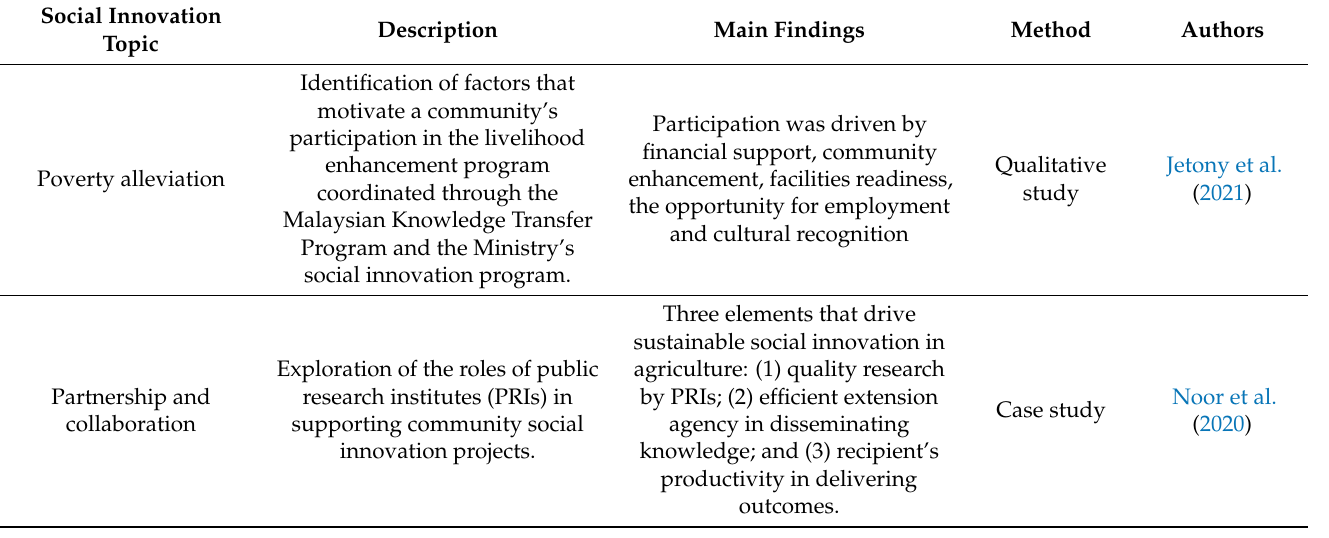
Table 1. A summary of the research findings on social innovation in